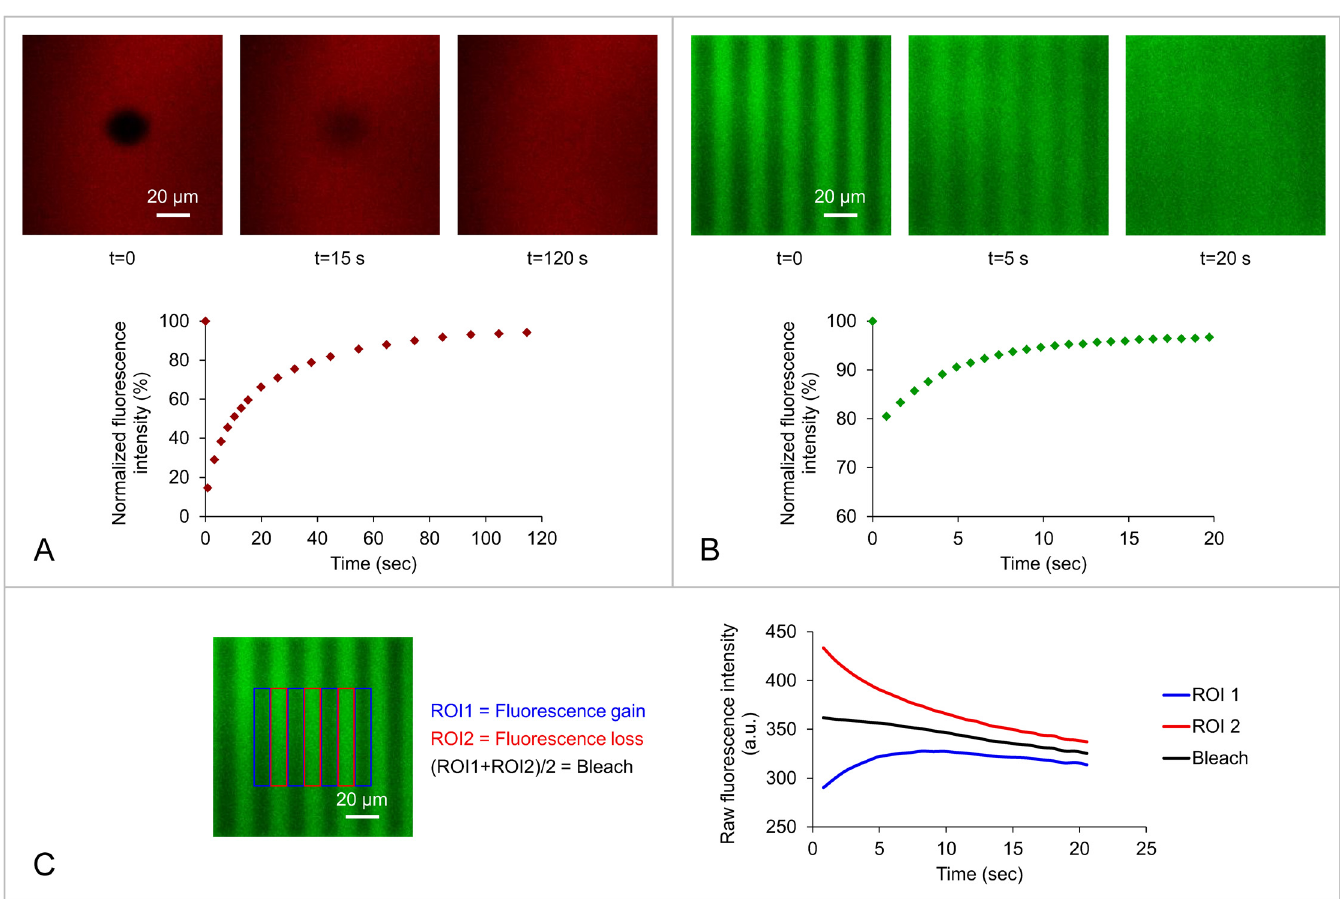
Fig 2. Fluorescence recovery of (A) DOPE-Rho or (B) DOPE-NBD lipids in the outer monolayer of a supported DOPC lipid bilayer following photobleaching of (A) a fluorescent disk of d = 20 μ m diameter or (B) a pattern of fluorescent fringes separated by f = 20 μ m. The recovery curve (result of 1 bleaching experiment on the same region in A and average of 3 bleaching experiments on the same region in B) can be fitted with (A) a Bessel function or (B) an Exponential function. (C) The contribution of the intrinsic photobleaching occurring during fluorescence reading (bleach) in the case of DOPE-NBD lipids can be removed in the fringe system by using the average of fluorescence gain in the dark fringes and fluorescence loss in the bright fringes. No intrinsic photobleaching was observed with DOPE-Rho